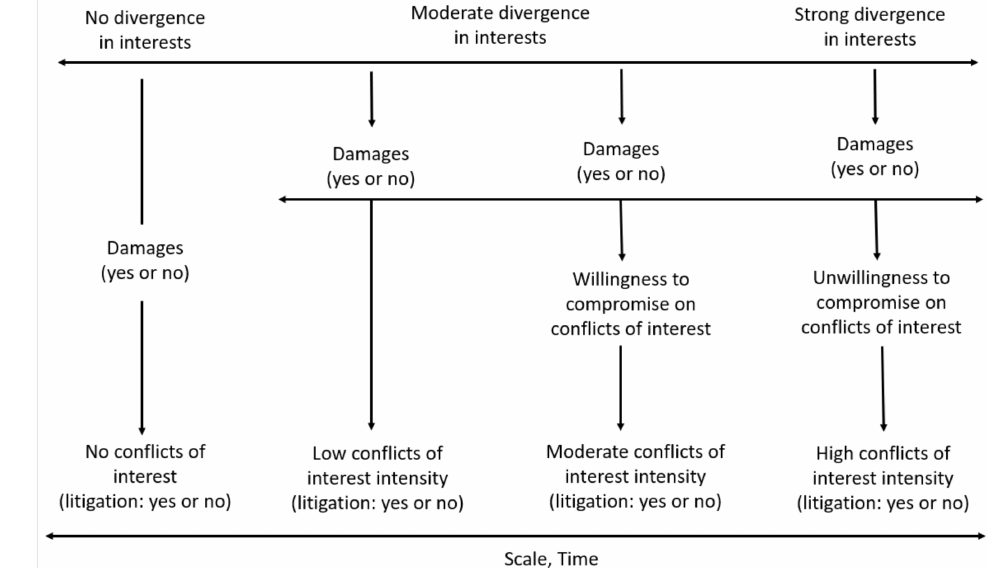
Figure 5. Intensity spectrum of conflicts of interest (COI) and potential climate change litigation (modified from Weible and Heikkila (2017)